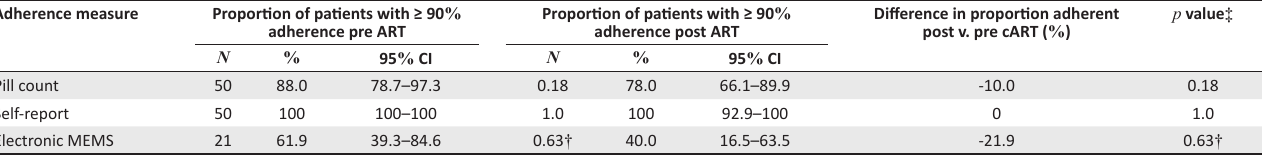
TABLE 2d: Ninety percent adherence to tuberculosis treatment before and after initiation of antiretroviral treatment. Adherence